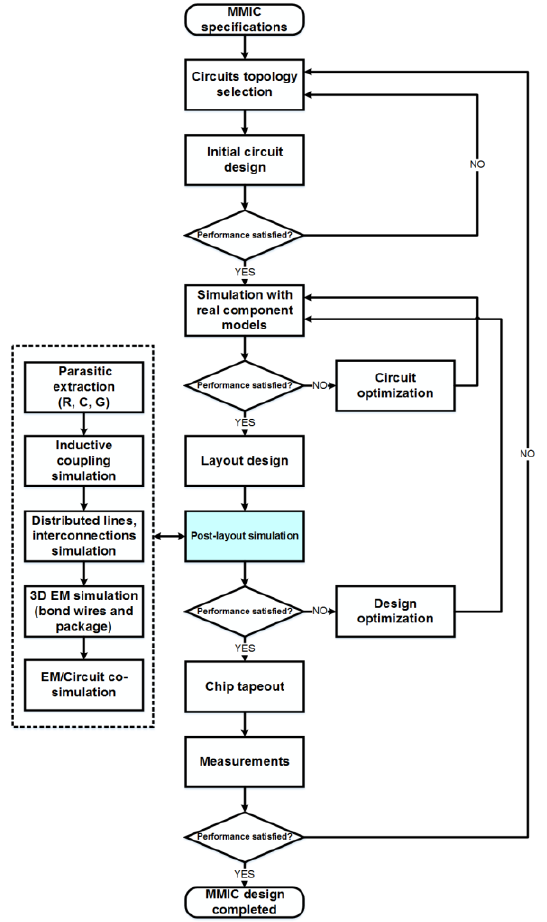
Fig. 1. MMIC design